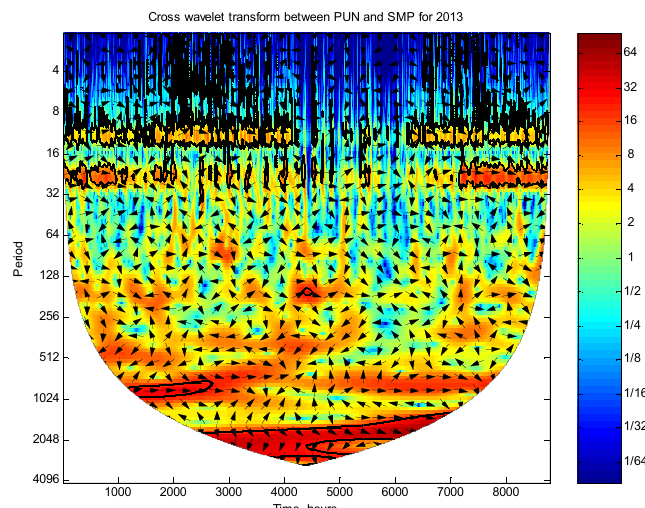
Figure 11. Cross wavelet transform (XWT) of the PUN and SMP for 2013. The 5% significance level against red noise is shown as thick contour. The relative phase relationship is shown as arrows (with in-phase pointing right, anti-phased pointing left and SMP leading PUN by 90° pointing straight